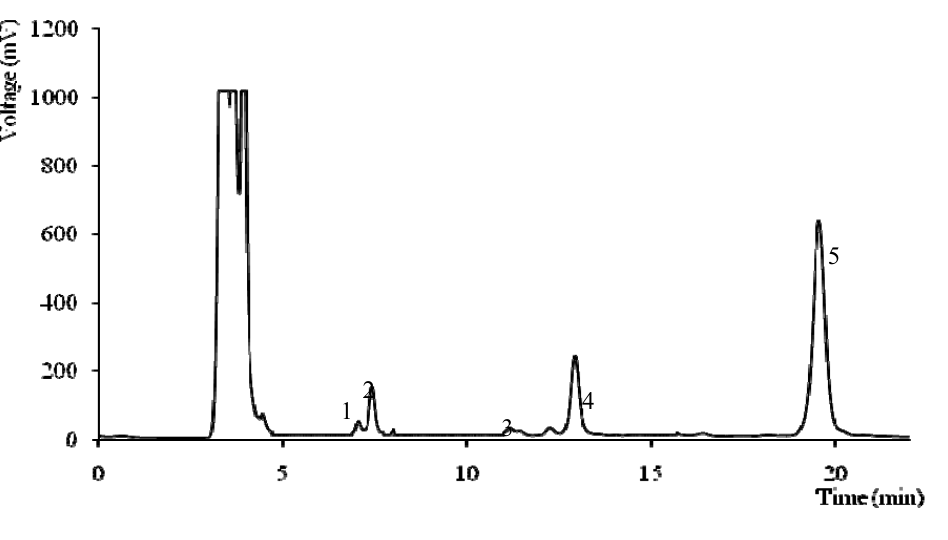
Figure 2. Individual tocopherols chromatogram of Lentinus tigrinus : 1- α -tocopherol; 2-BHT; 3- β -tocopherol; 4- γ -tocopherol; 5-tocol